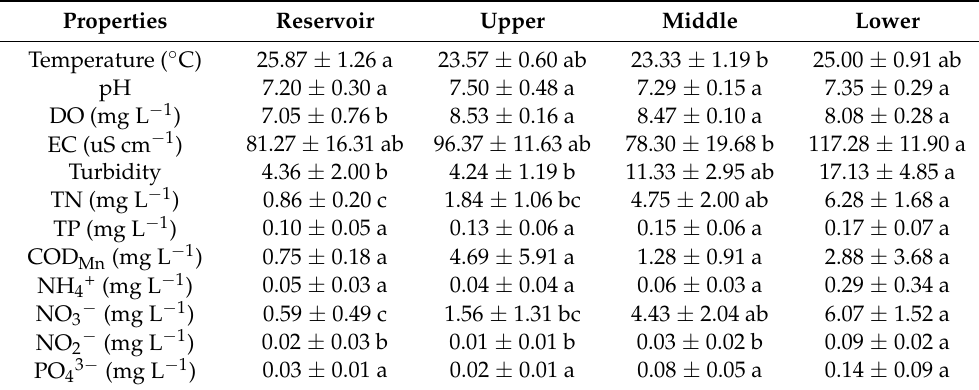
Table 1. Properties of water samples drawn from the Nandu River. Values are means ± SE, means not sharing any lowercase letter indicating significant differences among different groups.